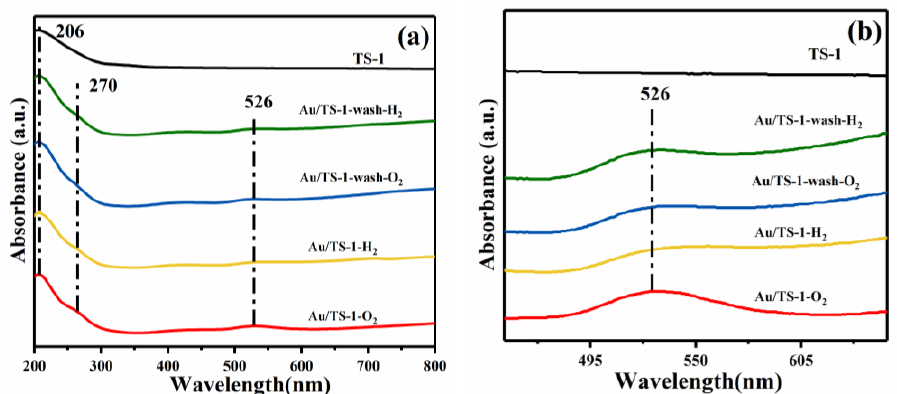
Figure 5. ( a ) UV-Vis spectra of TS-1 support and Au/TS-1 catalysts and ( b ) the enlarged region of the peak at 526 nm.